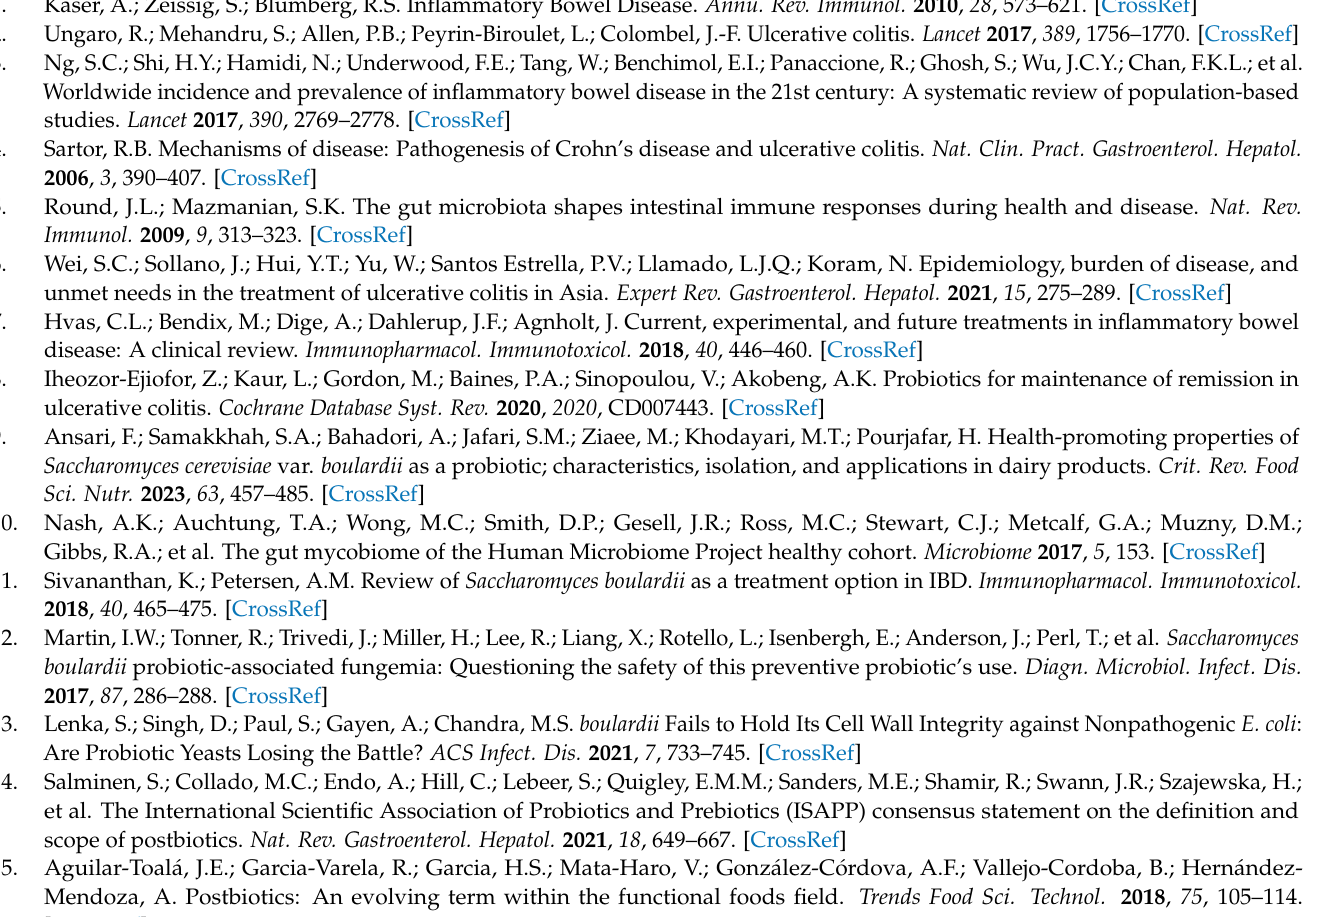
Table S2: Summary of major rodent studies investigating the protective effect of S. boulardii against dextran sulfate sodium (DSS)-induced ulcerative